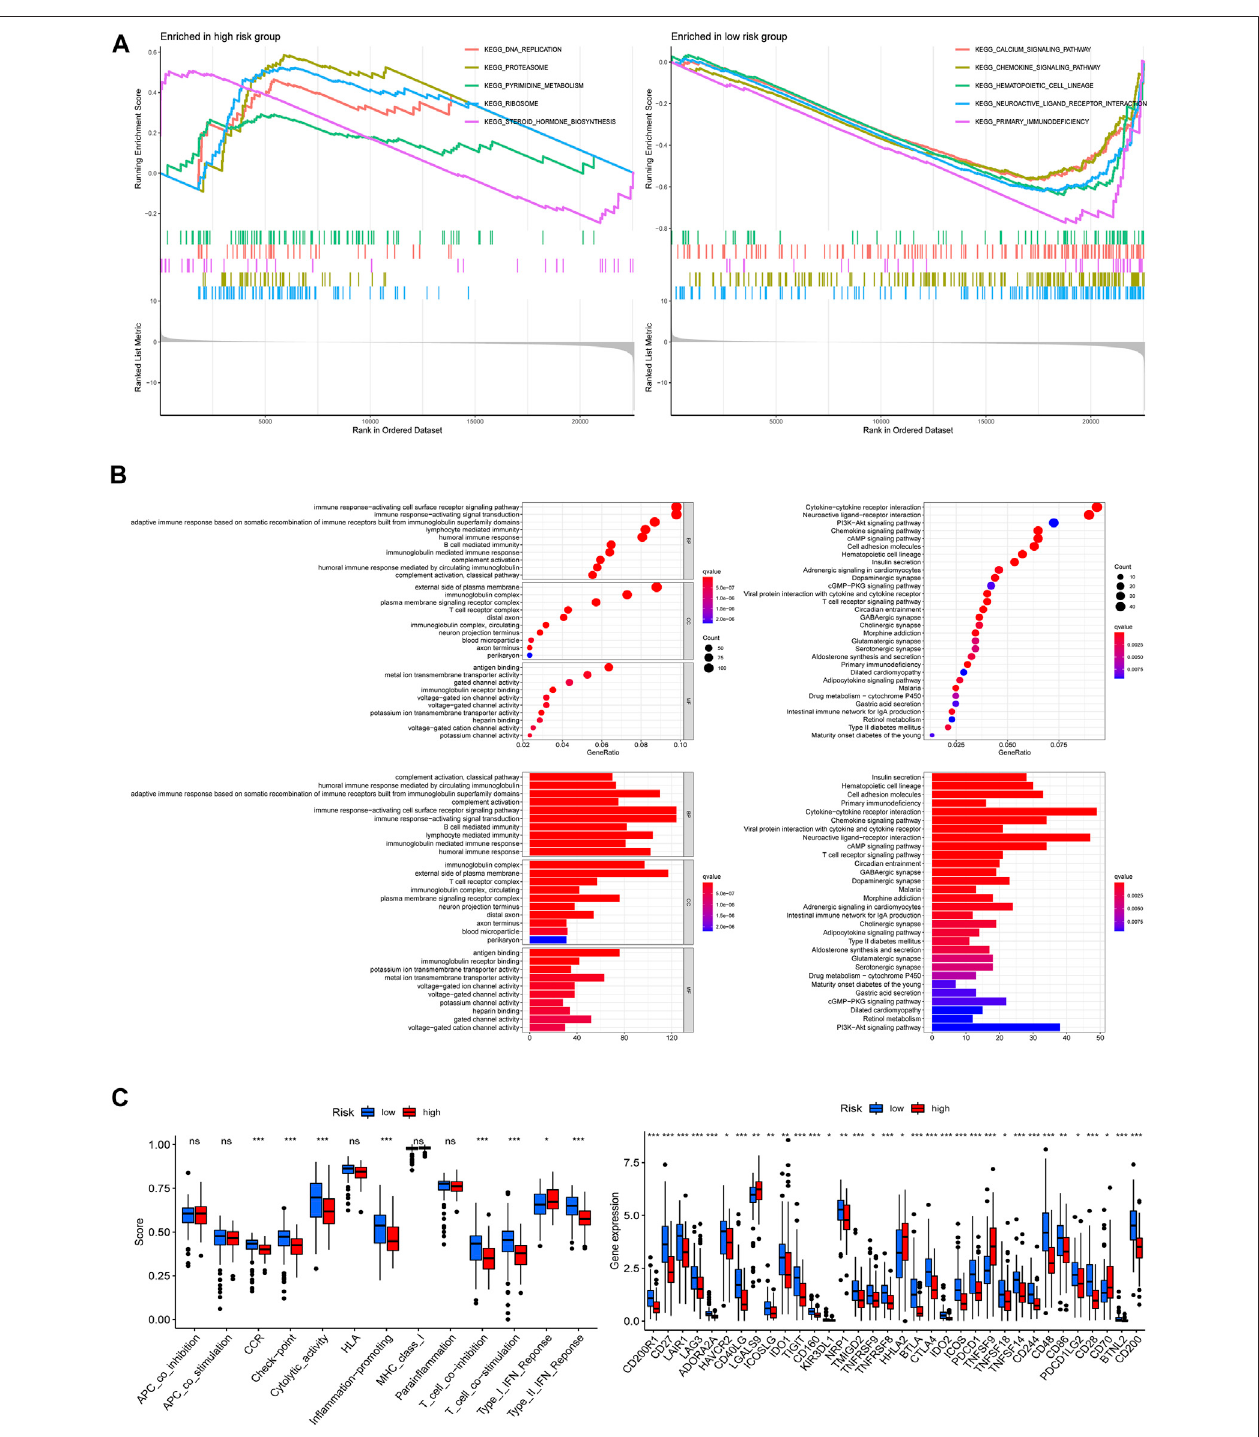
FIGURE 7 | Functional enrichment analysis. (A) Gene set enrichment analysis (GSEA) in both risk groups. (B) Differentially expressed genes between the two groups: Gene ontology (GO) enrichment analysis (left) and Kyoto Encyclopedia of Genes and Genomes (KEGG) pathway enrichment analysis (right). (C) Immune functions analysis: immune function scores between the two risk groups (left), expression patterns of immune checkpoint genes (right) (* p < 0.05; ** p < 0.01; *** p < 0.001; ns, not signi fi cant).